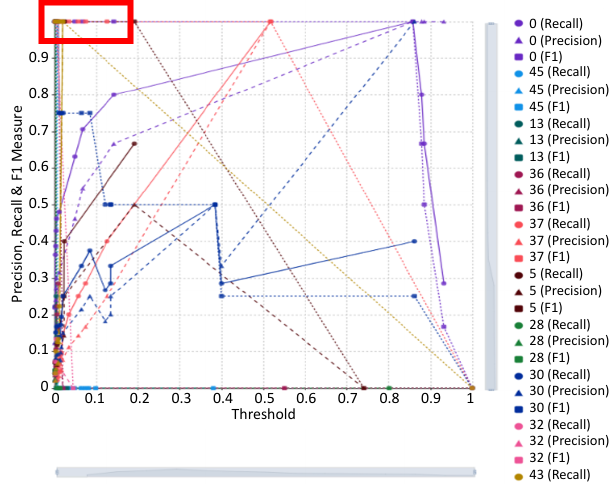
Figure 23. Accuracy of infividual speed